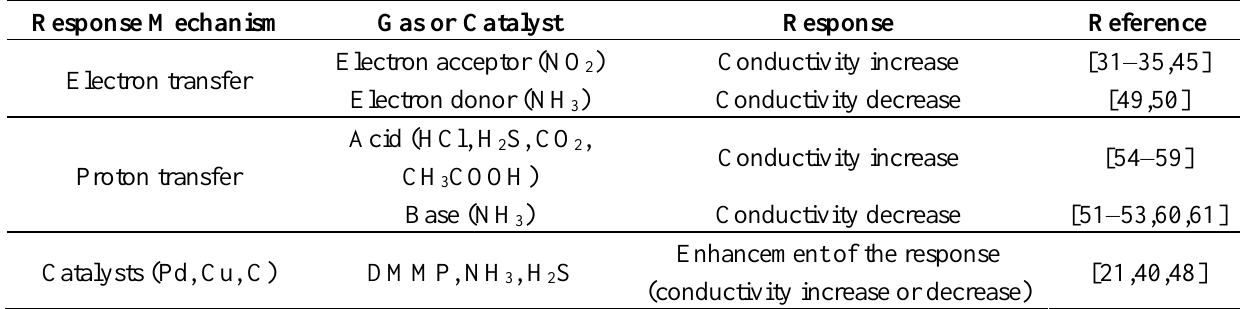
Table 3. Response mechanism of electrodeposited polymer-based gas